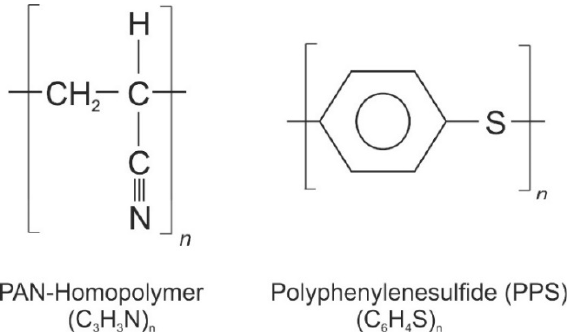
Figure 10. Chemical structures and sum formula of PAN-homopolymer and polyphenylene sulfide (PPS).